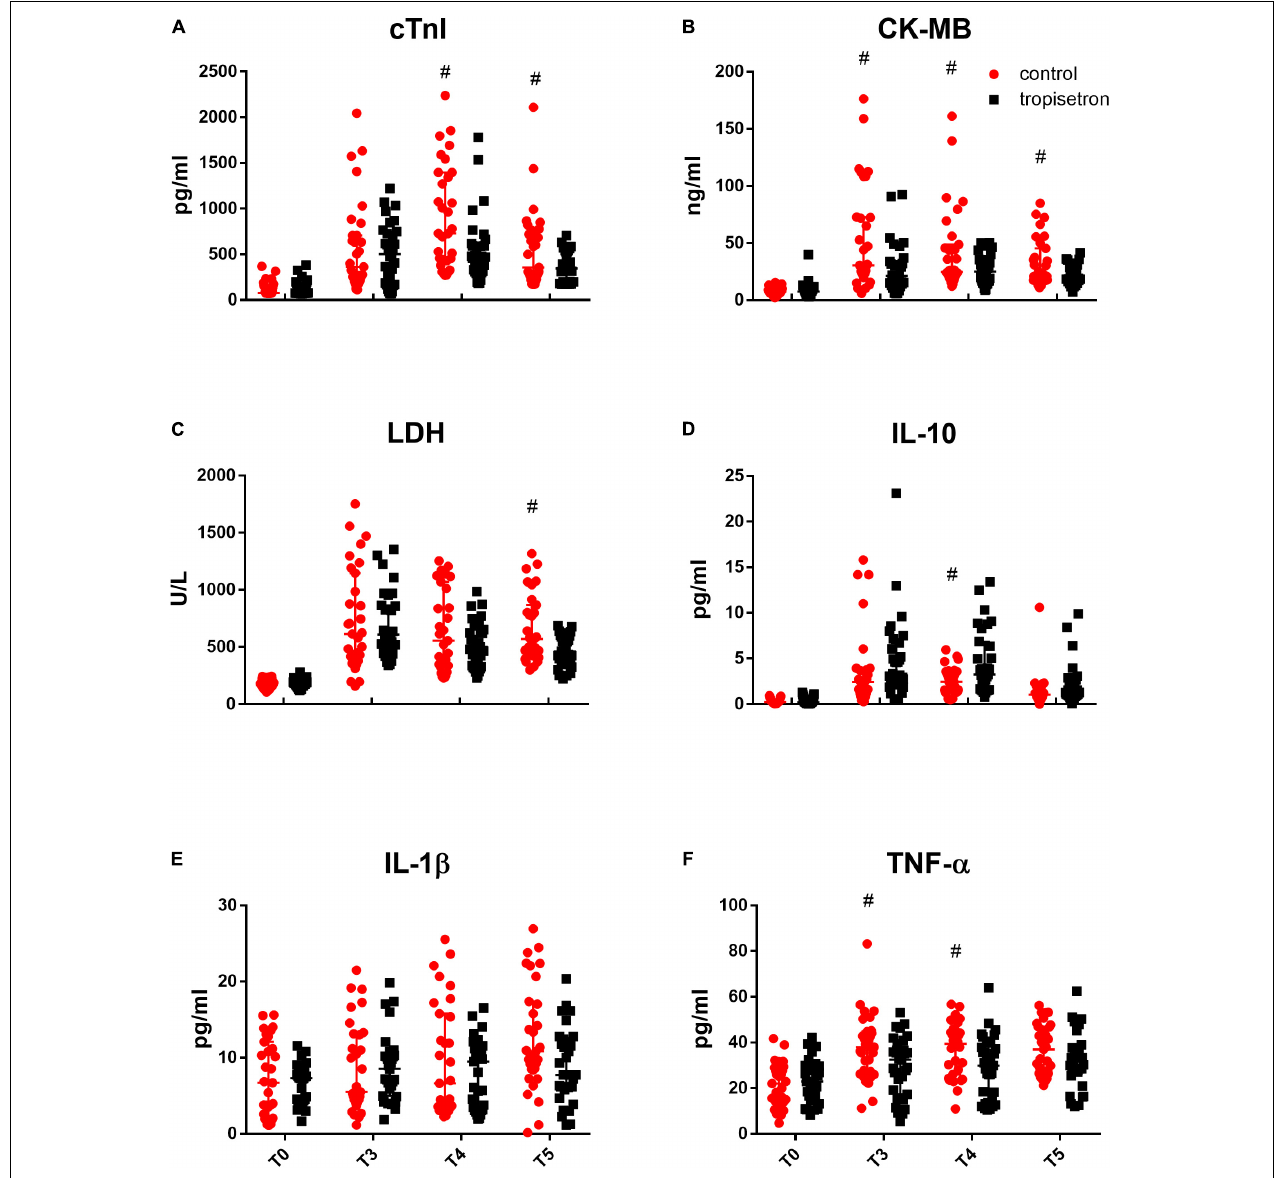
FIGURE 2 | Effect of TRP on perioperative myocardial biomarkers and inflammatory cytokines. Myocardial injury biomarkers, which include (A) cTnI, (B) CK-MB, and (C) LDH, increased after the release of aortic cross-clamp, while TRP treatment decreased that effect ( p < 0.05, two-way ANOVA for repeated measurements followed by Bonferroni post-hoc tests). Inflammatory cytokines, such as (D) IL-10, (E) IL-1 β , and (F) TNF- α , were increased, while TRP treatment increased IL-10 and decreased TNF- α levels compared with the control group after the release of the aortic cross-clamp ( p < 0.05, two-way ANOVA for repeated measurements followed by Bonferroni post-hoc tests). # P < 0.05 compared with the control